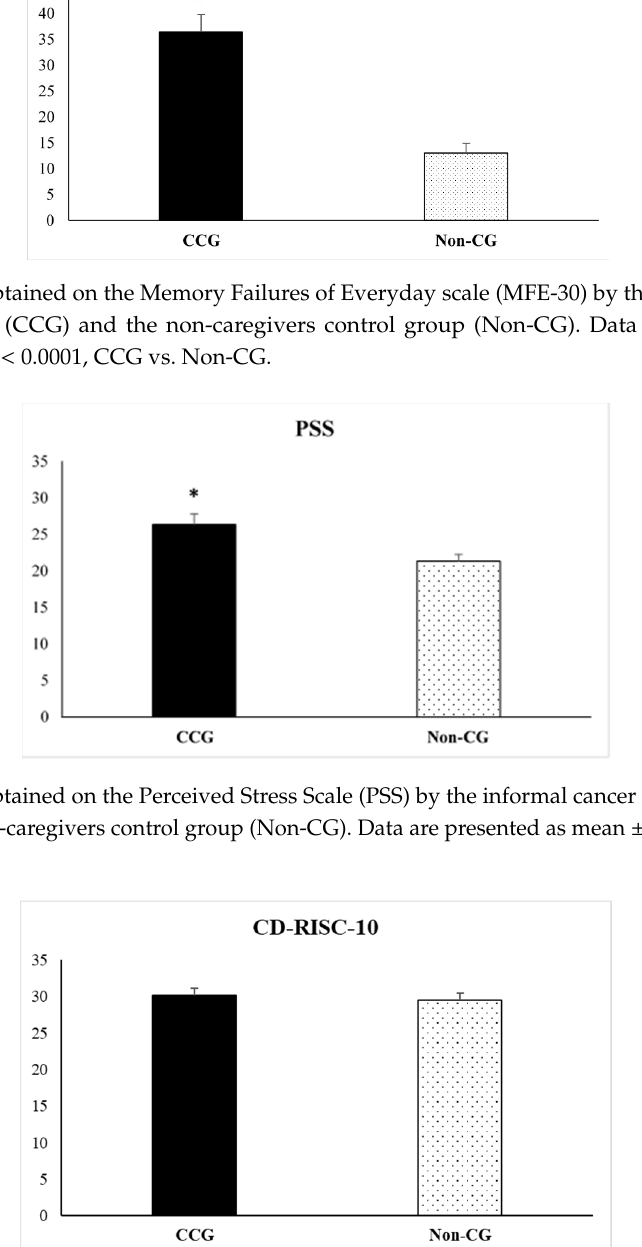
Figure 3. Scores obtained on the Connor-Davidson Resilience Scale (CD-RISC-10) by the informal cancer caregiver’s group (CCG) and the non-caregivers control group (Non-CG). Data are presented as mean ± SEM.